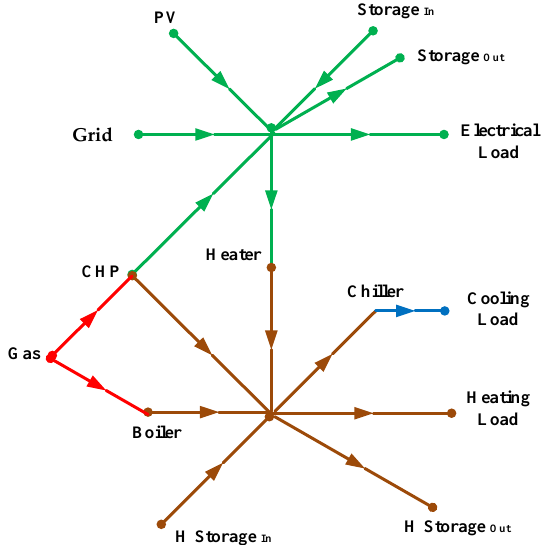
Figure 4. Illustration of the EH modelled based on matrix approach.